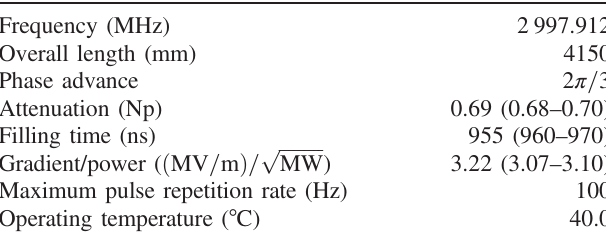
TABLE V. Main parameters of the S-band booster constant- gradient structures. Where available and of relevance measured values are given in brackets.